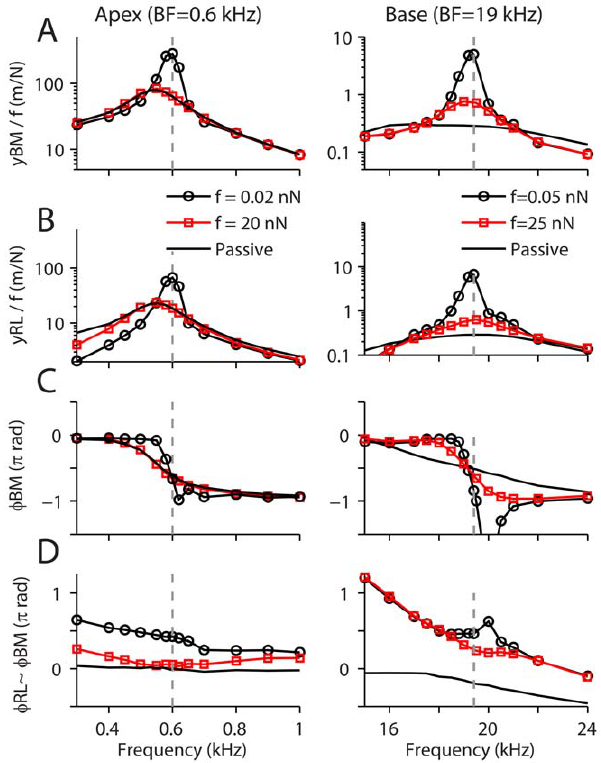
Figure 4. Response of cochlear partition to pure tone stimuli. A sinusoidal force was applied to the basilar membrane (centered at z =0 with normal longitudinal distribution s z =100 m m). Three cases were simulated: stimulation with small and large force (lines with circle or square symbols) and without active feedback from OHCs (solid lines). ( A ) Basilar membrane displacement normalized by applied force. ( B ) Reticular lamina displacement in the y-direction normalized by the applied force. ( C ) Phase of the basilar membrane displacement with respect to the applied force. ( D ) Phase of the reticular laminar y- displacement with respect to the basilar membrane displacement. Note the responses to large stimuli approximate the passive condition in which active OHC feedback is